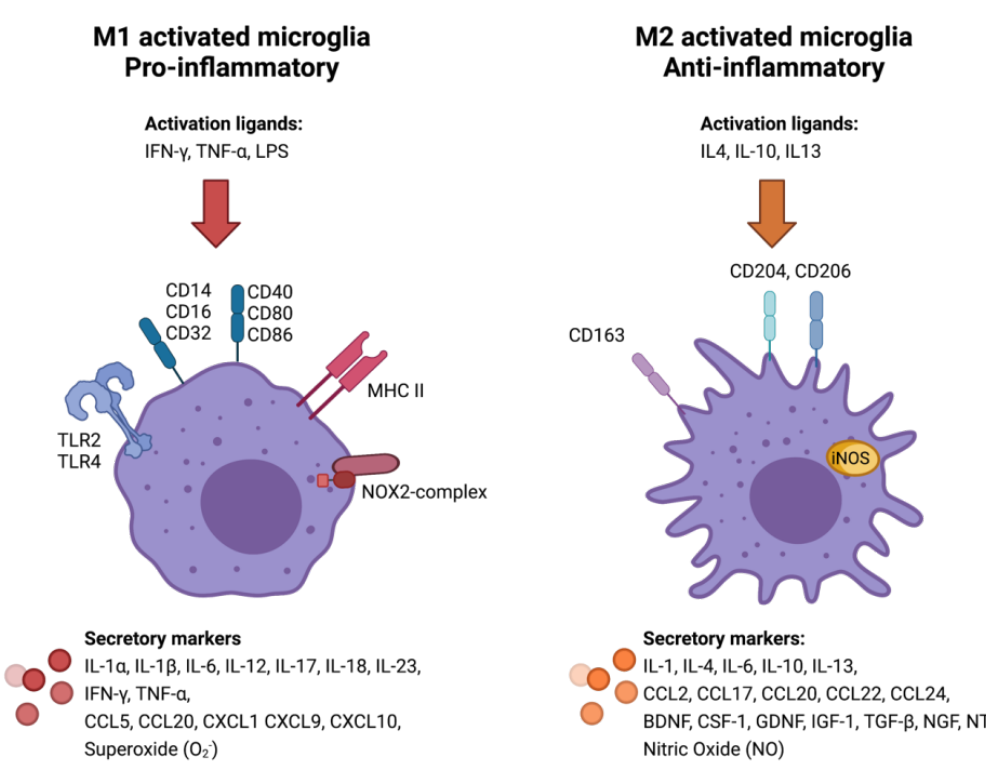
Figure 1. Surface and secretory markers associated with M1/M2 polarisation state of microglia [13,27,30–33].